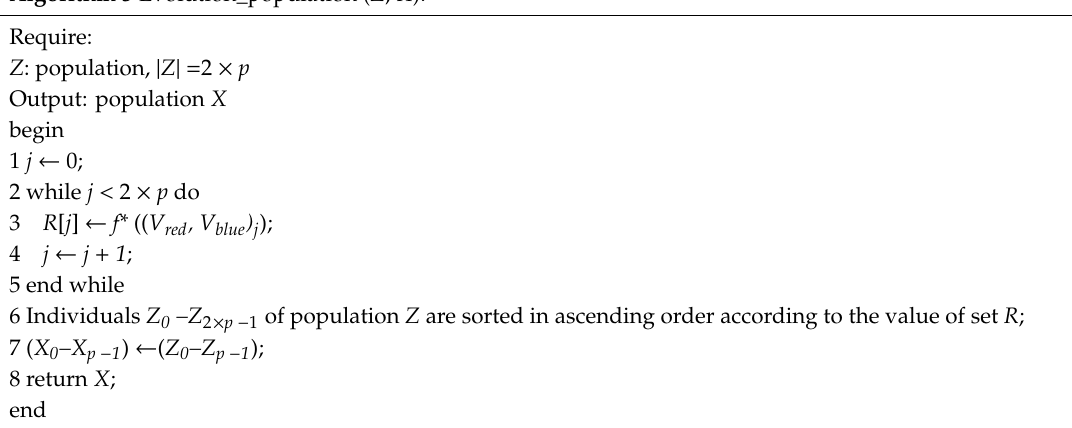
Algorithm 3 Evolution_population ( Z , X ).